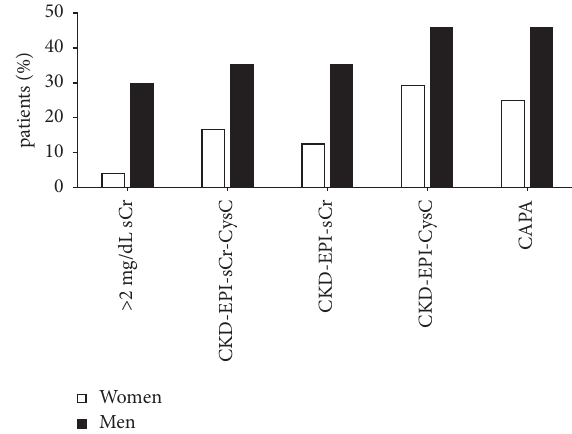
Figure 1: Newly diagnosed multiple myeloma patients with renal impairment, according to international myeloma working group criteria (categorized by sex) using serum creatinine and cystatin C in different